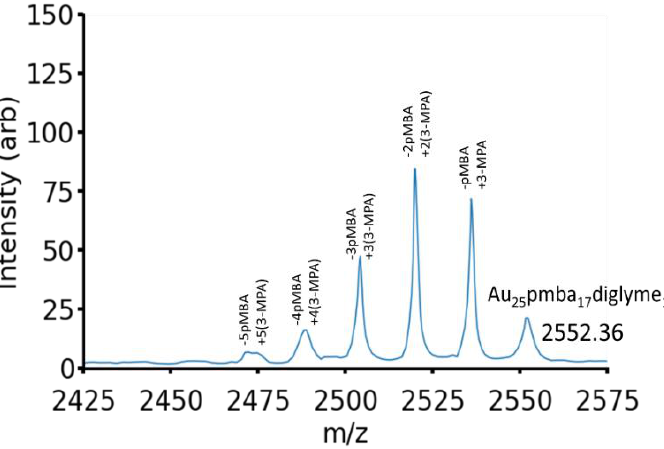
Figure 3. ESI-MS spectra of ligand exchange of Au25pMBA 17 diglyme 1 with 3-mercaptopropionic acid. The furthest right peak can be attributed to the −5 charge state of Au25pMBA 17 diglyme 1 . Each subsequent peak to the left correlates to the exchange of a pMBA ligand for an incoming 3-MPA ligand.